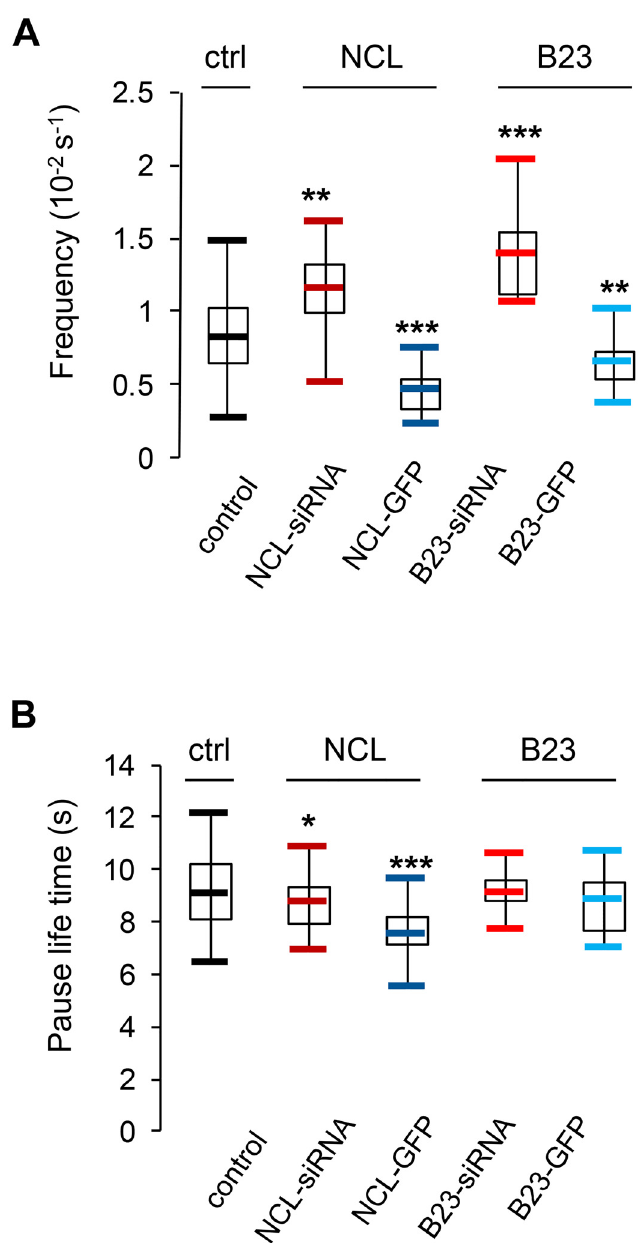
Fig 5. Nucleolin expression affects microtubule pauses. Analysis of pause events in control [black], nucleolin depleted [dark red], nucleolin over expressing [dark blue], B23 depleted [light red] and B23 over expressing cells [light blue]. The asterisks indicate that the mean value differs from the control condition with the Wilcoxon-Mann-Whitney two-sample rank test at different significance levels: 10% ( * P < 0.1), 5% ( ** P < 0.05), 0,5% ( *** P < 0.005). (A) Pause frequency (10 -2 s -1 ) is calculated by dividing the number of pause events by the time microtubules spend in growth. Cells were individually analyzed (control: 18 cells; NCL- siRNA: 24 cells; NCL-GFP: 15 cells; B23-siRNA: 11 cells; B23-GFP: 15 cells). (B) Pause life time (s) represents the mean time between the disappearance and the recovering of EB3-TagRFP signal during pause